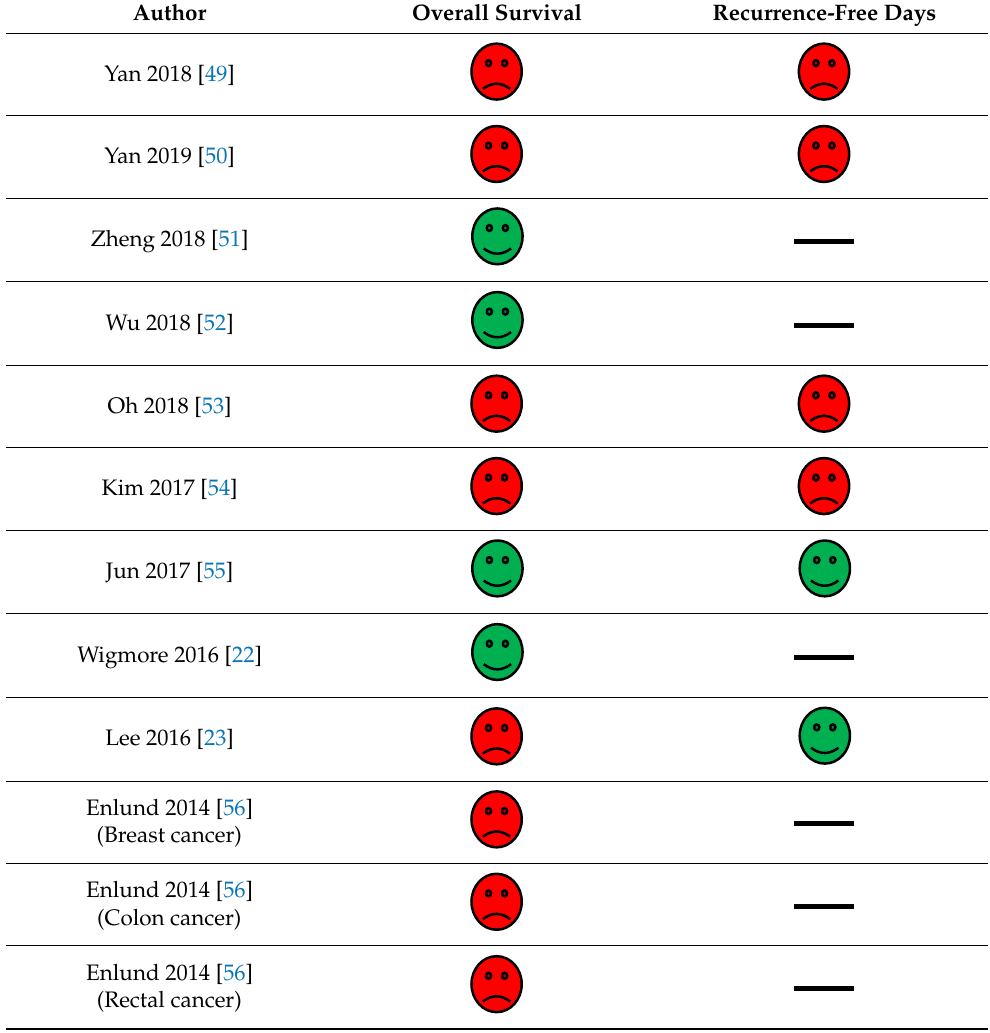
Table 1. Studies investigating the effect of intravenous anesthetics versus inhalation anesthetics on overall survival and cancer-free survival.